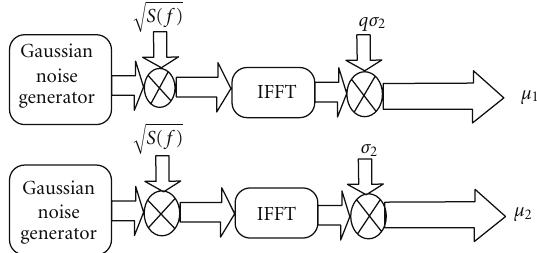
Figure 2: Block diagram of IFFT based